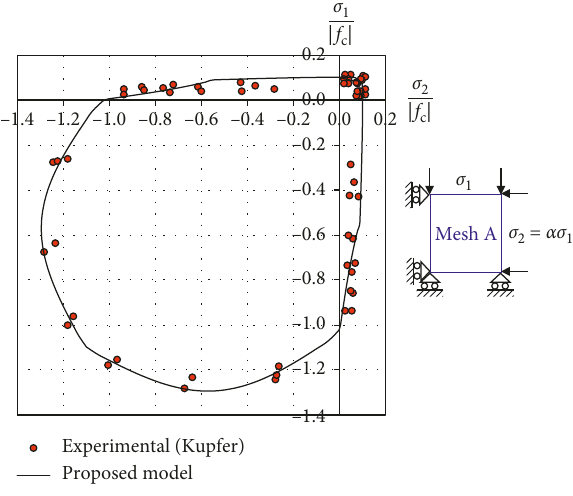
Figure 6: Biaxial strength envelope of